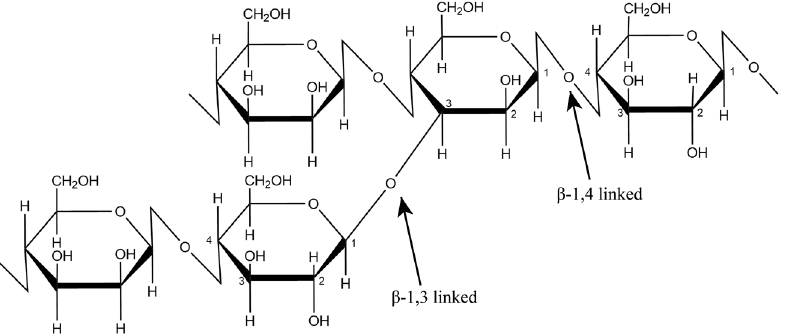
Figure 4. Structure of glucomannan.